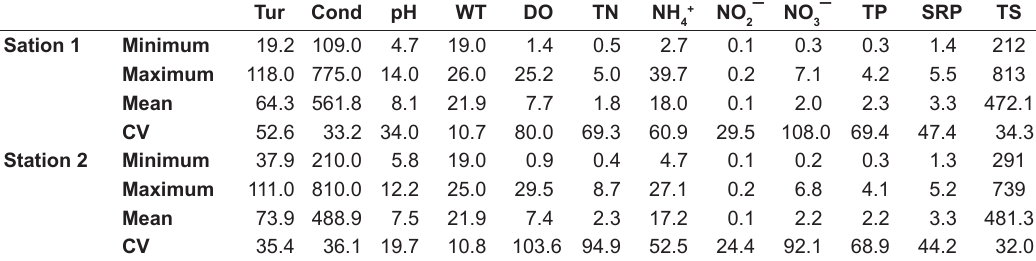
Table 1. Minimum, maximum and mean values and coefficient of variation (CV) of abiotic variables in the stabilization ponds.